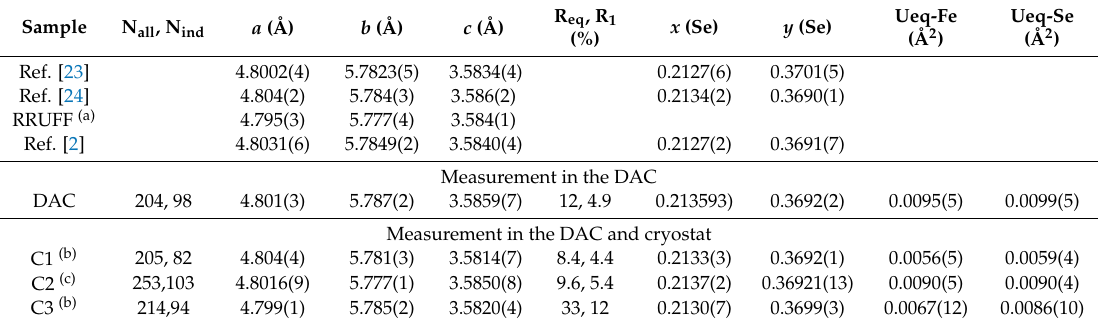
Table 1. Ambient-conditions unit-cell parameters and atomic fractional coordinates from the literature and from this work (see